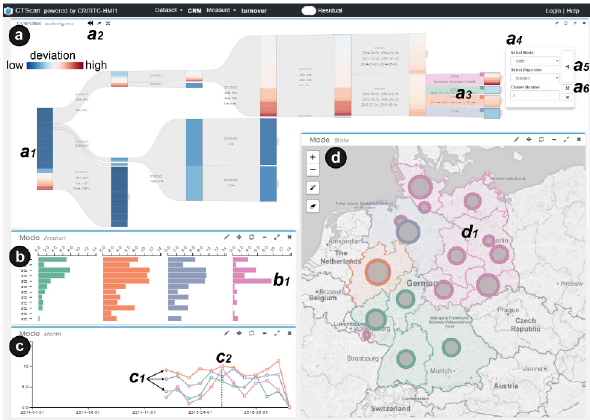
Fig. 11 Interface of TPFlow, a visual analytics system that supports steering tensor decomposition and analysis of spatiotemporal patterns. Reproduced with permission from Ref. [25], c (cid:13) IEEE